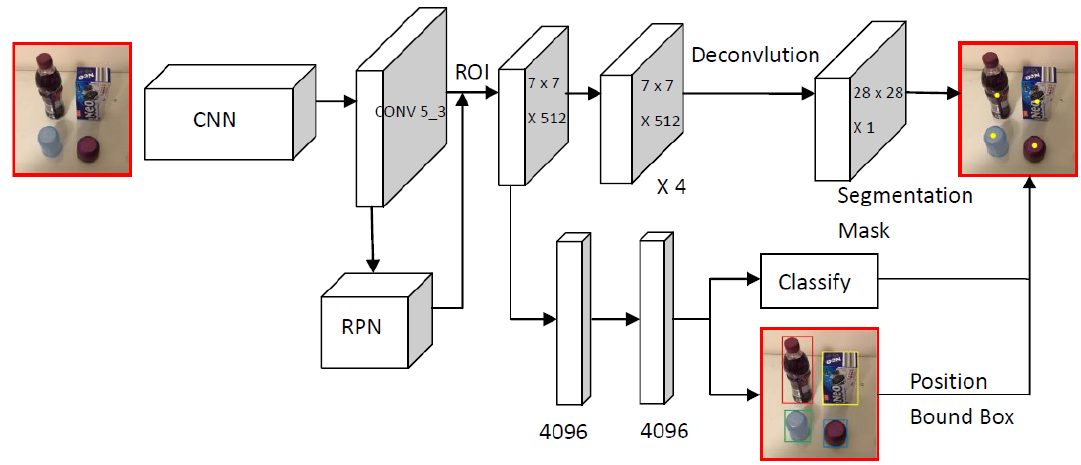
Figure 1. [15]. The Mask R-CNN network. Figure 1. Ref. [15]. The Mask R-CNN